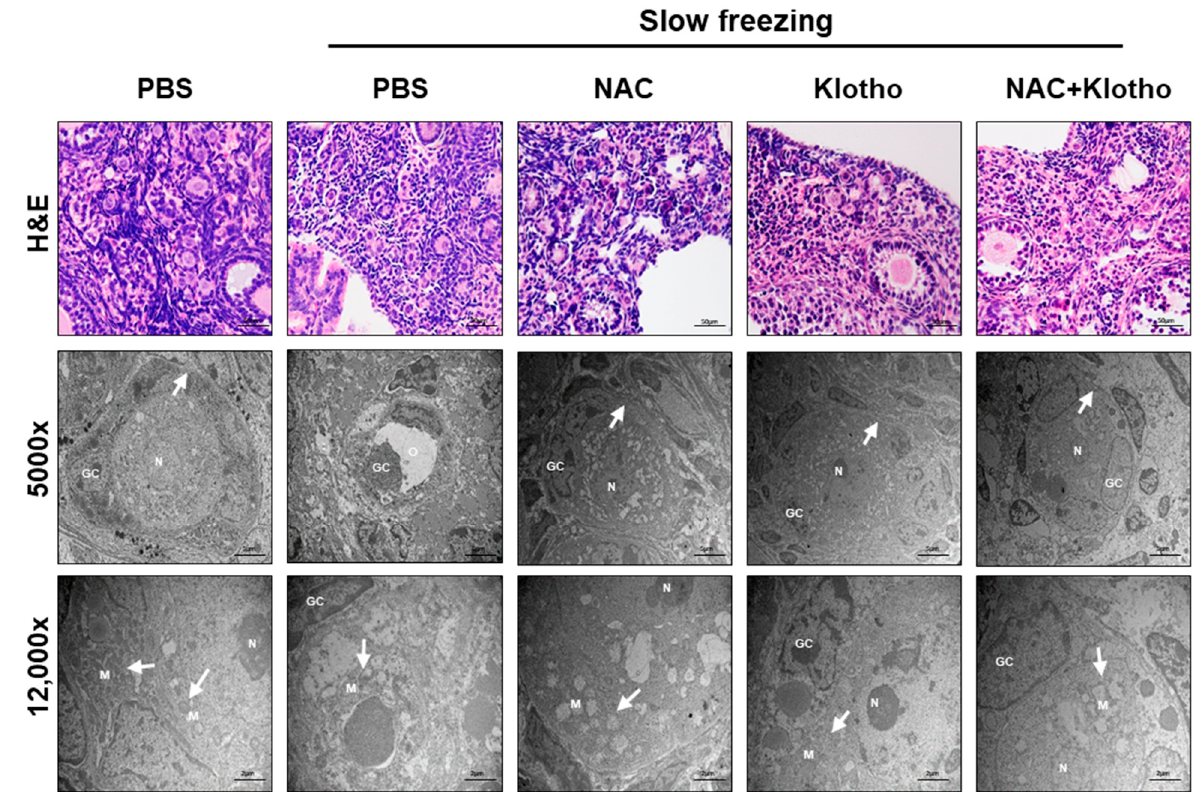
Figure 1. Effect of NAC and klotho proteins on mouse primordial follicle and mitochondrial morphology after slow-freezing cryopreservation. H&E staining was performed to determine the morphological changes in the mouse ovarian tissue after cryopreservation ( top ). Electron micrograph of a mouse primordial follicle showing flattened granulosa cells (GC), nucleus (N), mitochondria (M), and basal lamina (white arrow) (5000× magnification; middle ). Changes in mitochondrial morphology (white arrow) under the indicated conditions (12,000× magnification; bottom ). n = 2 each group.